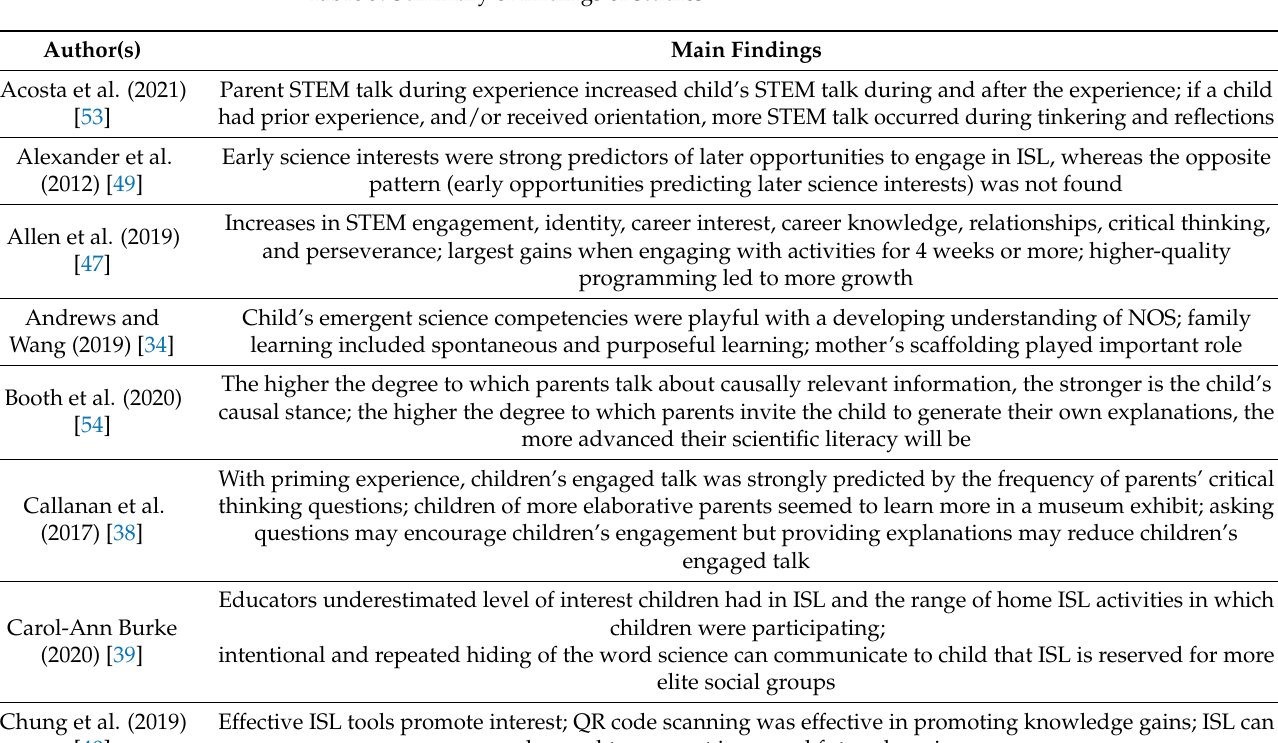
Table 3. Summary of findings of